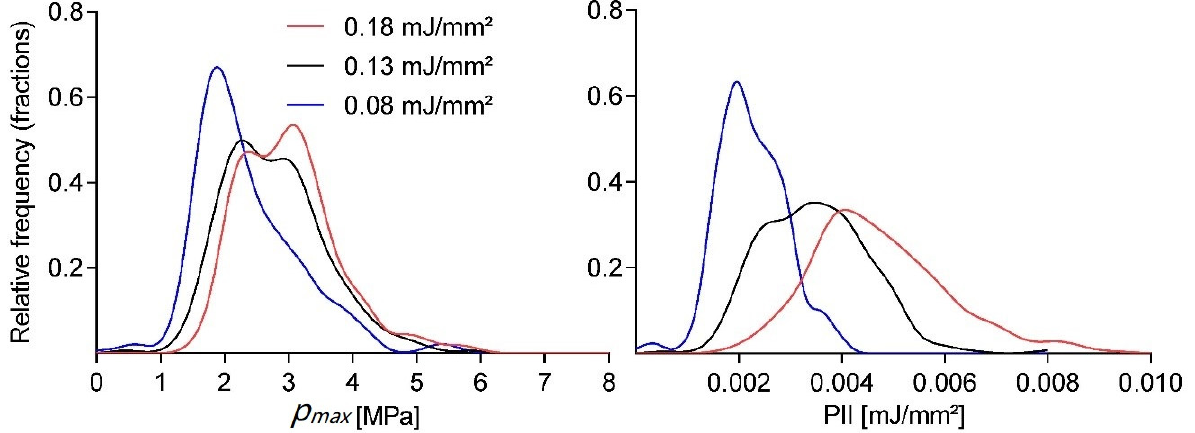
Figure 2. Normalized smooth histogram of 1200 shots for OP155 maximum pulse pressure ( p max ) and pulse integral intensity (PII) measurements at three nominal machine settings and 3 Hz applica- tion